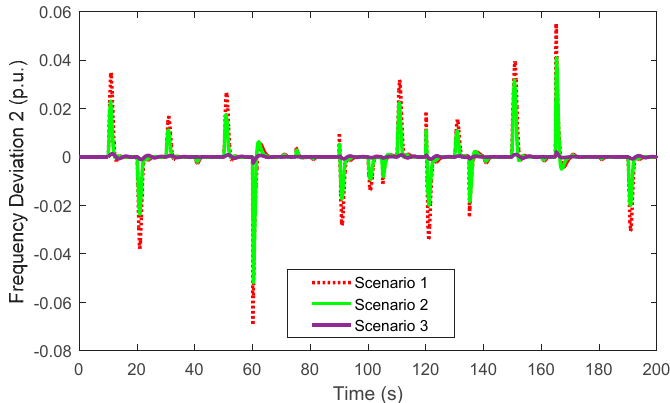
Figure 11. Comparison of the frequency deviations of microgrid 1 in the three scenarios.